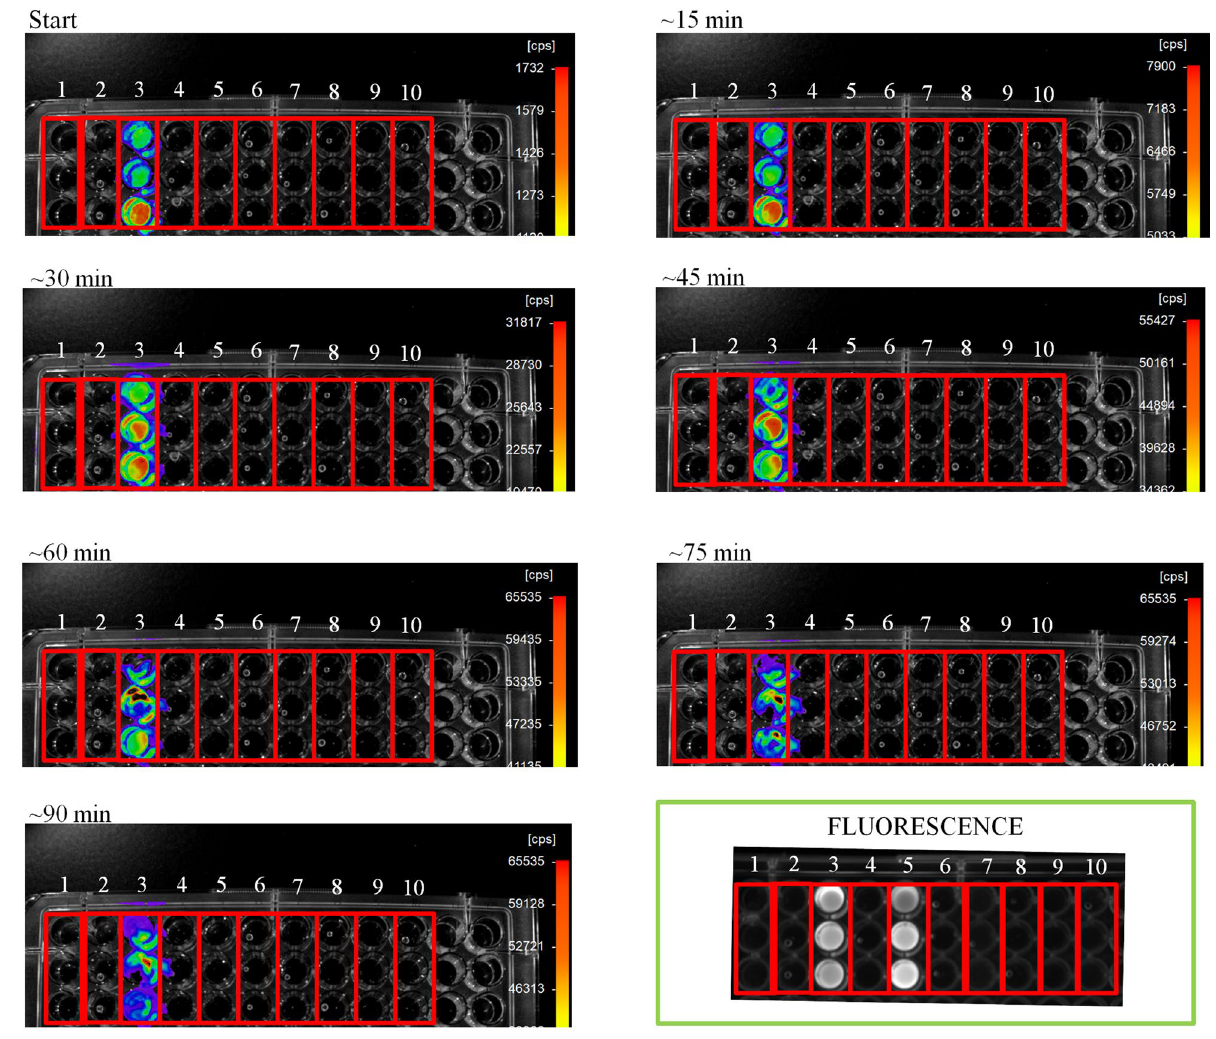
Figure 1. (Panels 0 to ~ 90 min) CCD bioluminescence detection of in vitro luciferin formation from d-cystein and p -benzoquinone (wells 3). (Panel “FLUORESCENCE”) fluorescence of luciferin upon UV irradiation also indicates luciferin formation from d-cysteine and p -benzoquinone in well 3, and from l-cysteine and p -benzoquinone in well 5. (1) Buffer + MgATP; (2) Buffer + MgATP + AmyLuc; (3) Buffer + MgATP + AmyLuc + d-cys + BQ; (4) Buffer + MgATP + AmyLuc + d- Cys; (5) Buffer + MgATP + AmyLuc + l-cys + BQ; (6) Buffer + MgATP + AmyLuc + l-cys; (7) Buffer + MgATP + AmyLuc + l-cys; (8) Buffer + MgATP + AmyLuc + d-cys + Hydroquinone; (9) Buffer + MgATP + AmyLuc + l-cys + Hydroquinone; (10) Buffer + MgATP + AmyLuc +